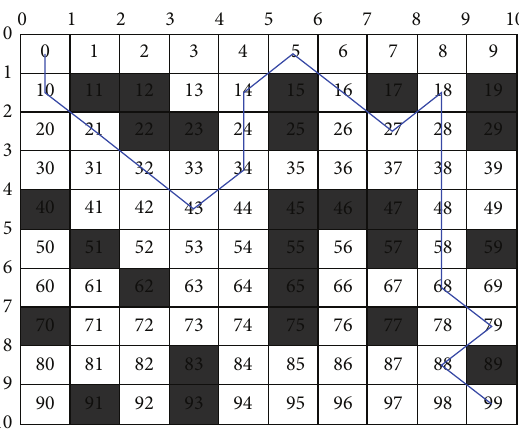
Figure 5: Route after operation of abandoning